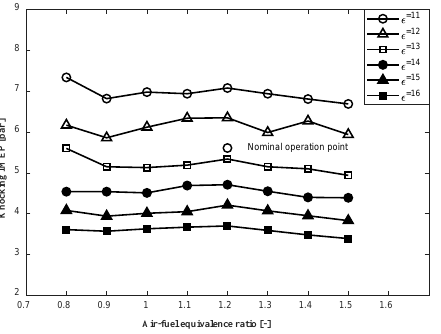
Figure 6. Knocking IMEP variation with the air–fuel equivalence ratio at different compression ratios (Engine A).